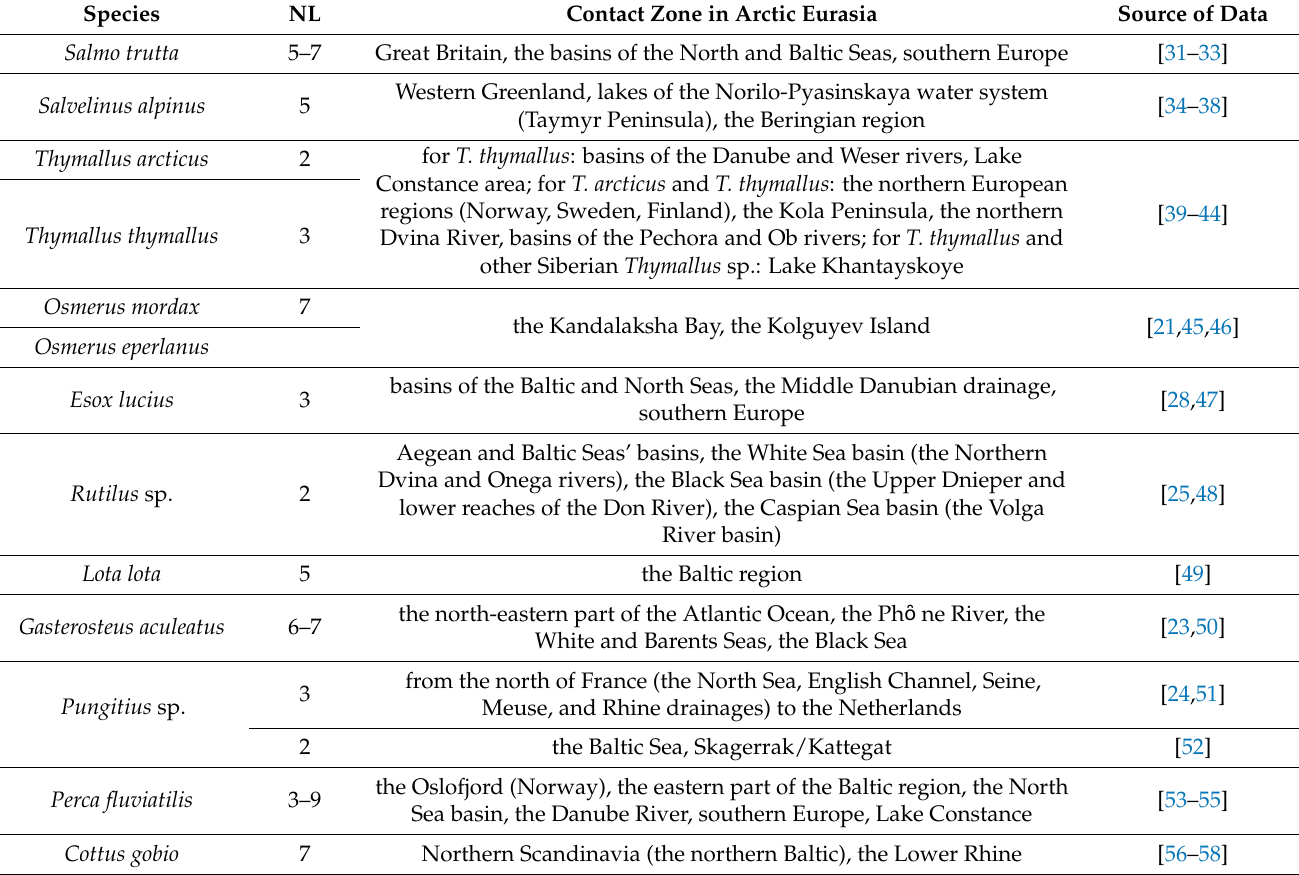
Table 1. The contact zone regions of the main species of Eurasian cold-water ichthyofauna.